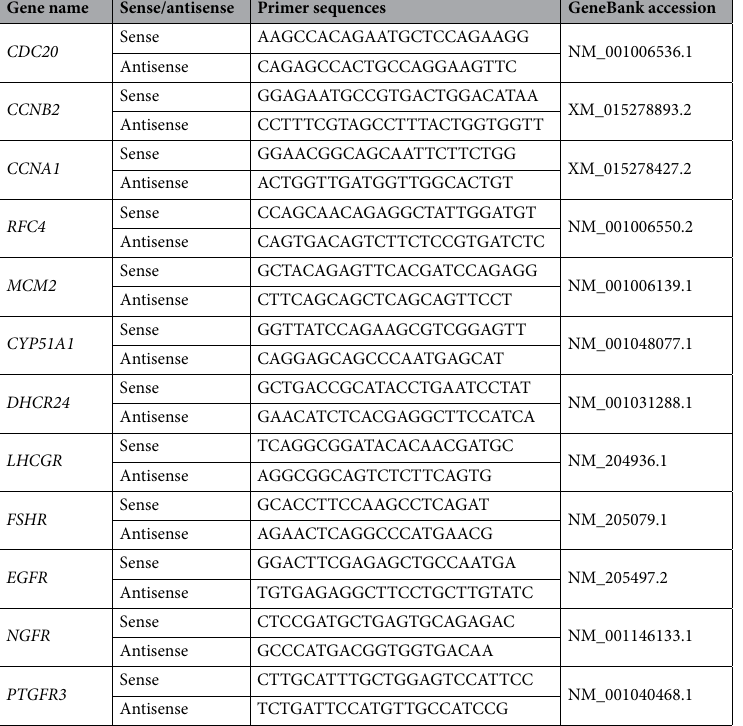
Table 1. Primers used for quantitative real-time PCR validation.